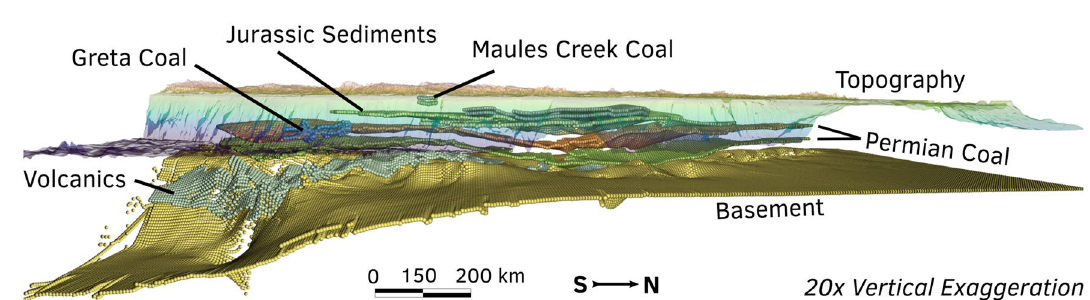
Figure 2. 3D stratigraphy of the Sydney–Gunnedah–Bowen Basin. The vertical spacing of layers has been exaggerated for visual clarity. The model of the basin was rendered in 3D using Underworld 18